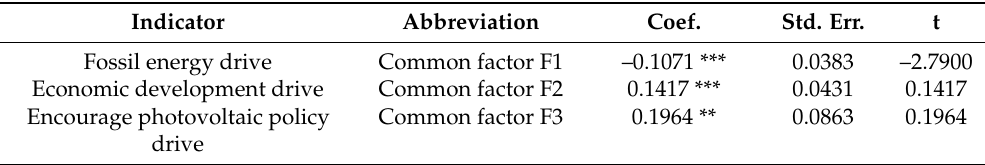
Table 4. Key Factors Regression